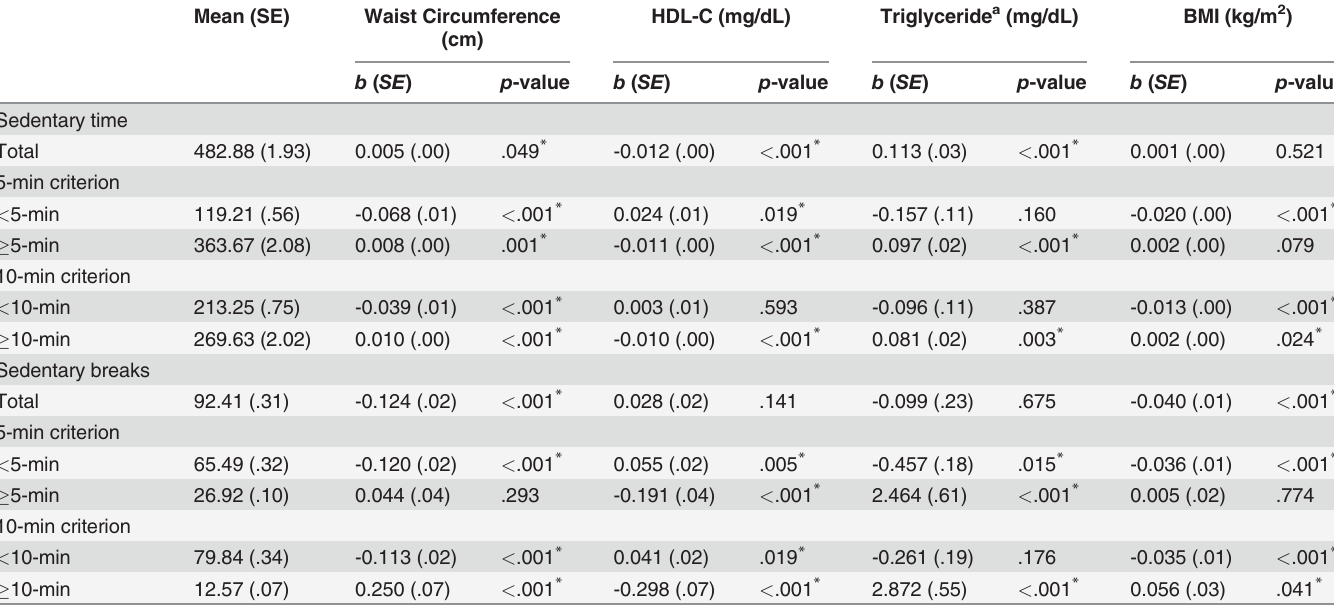
Table 5. Associations of Accelerometer Determined Sedentary Behavior Measures with Health Outcomes across Different Bout Duration Conditions ( n = 5,917). Mean